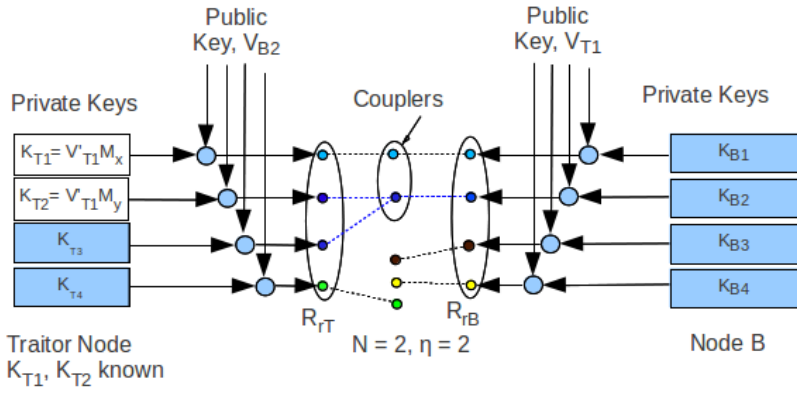
Figure 4. The traitor node can be used to attack private-public-master-key associations (PPMka).